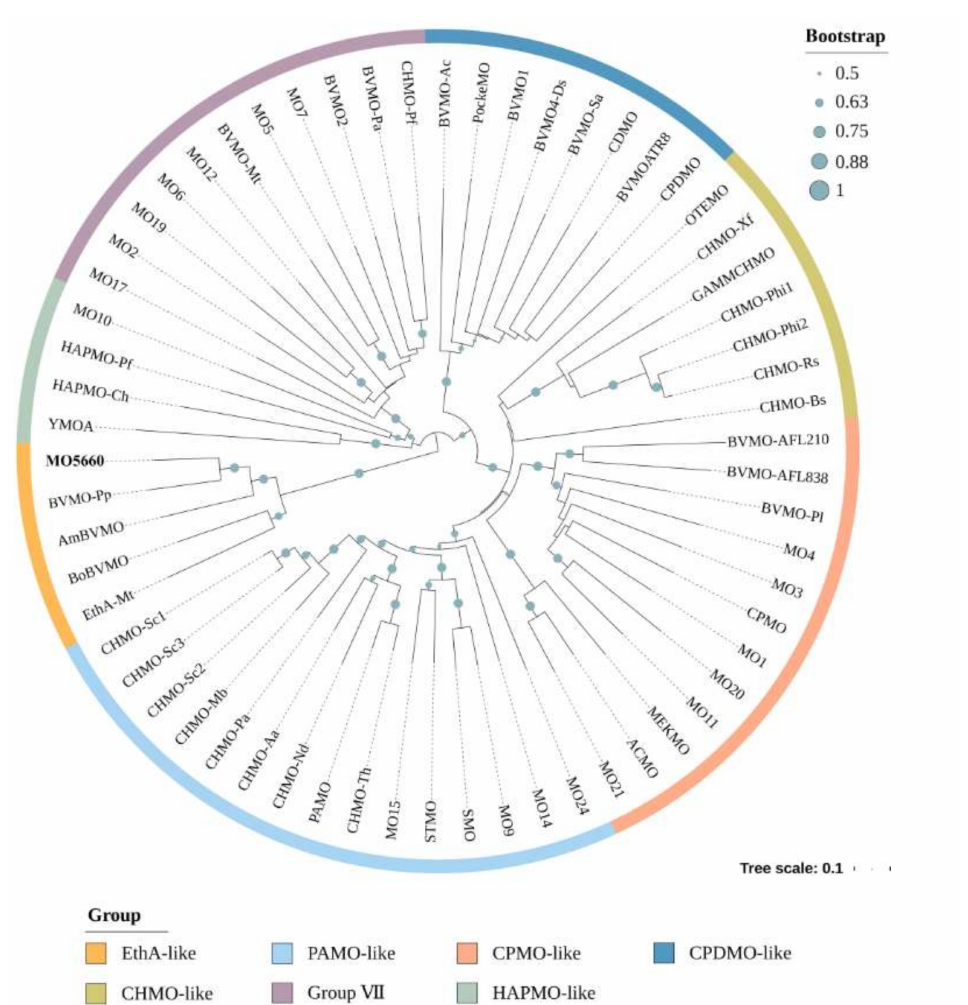
Figure 5. Phylogenetic tree including MO5660. Bootstrap values of more than 500 (from 1000 replicates) are marked with circles of different